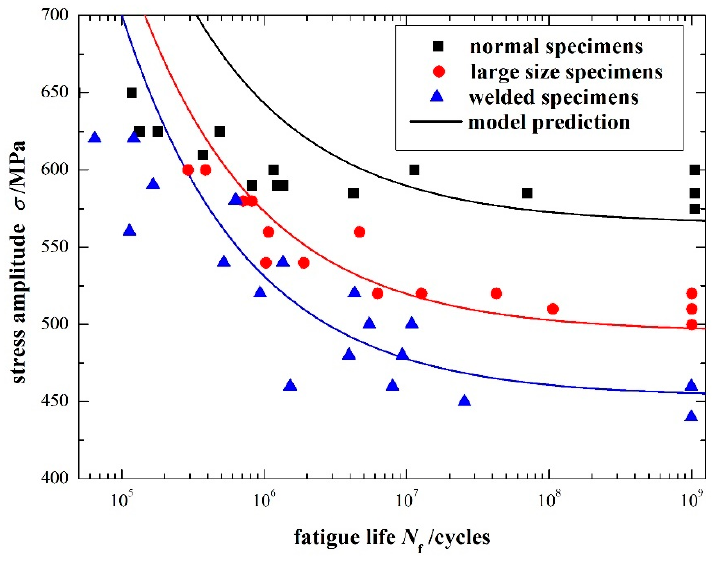
Figure 15. Very high cycle fatigue life prediction model of KMN-I.